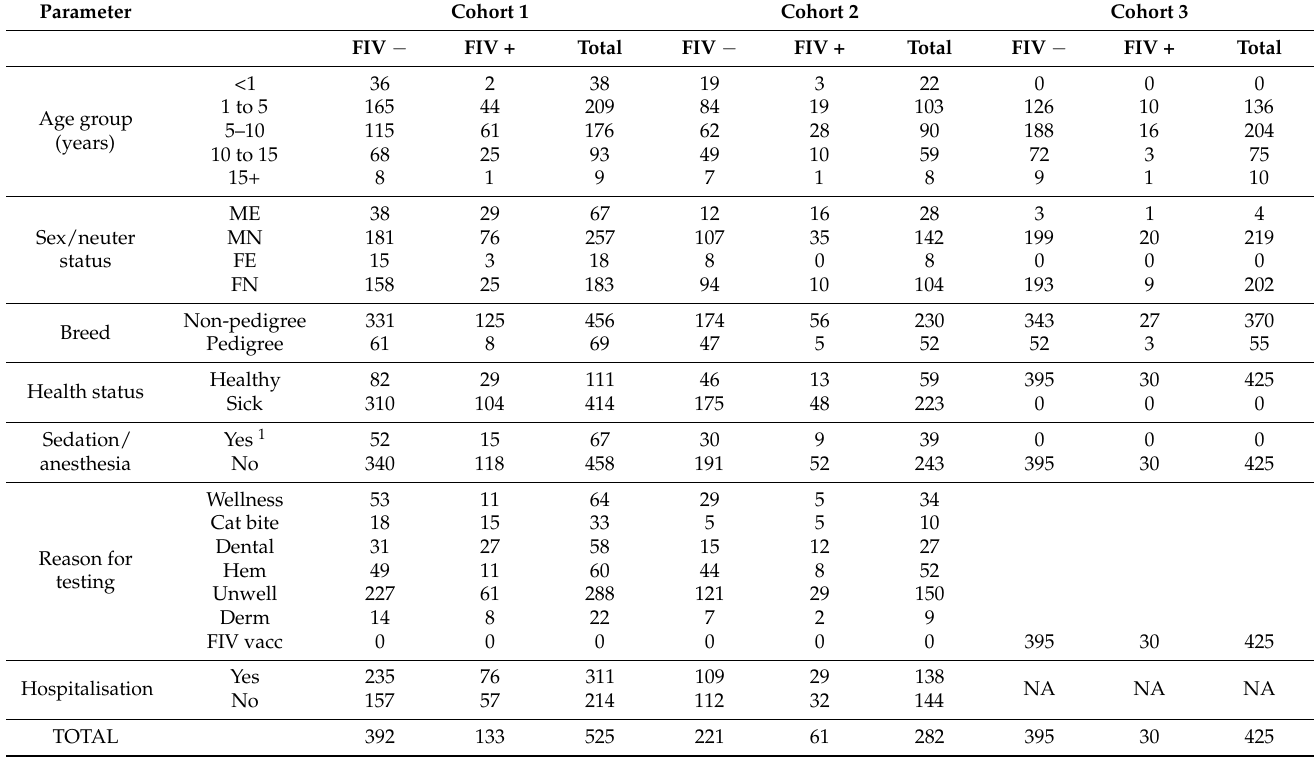
Table 1. Signalment details for cohort 1 ( n = 525; in-house hematology and blood biochemistry testing), cohort 2 ( n = 282; external hematology and blood biochemistry testing) and cohort 3 ( n = 425; FIV vaccine efficacy study). ME = male entire, MN = male neutered, FE = female entire, FN = female neutered. Wellness = wellness examination, Cat bite = cat fight wounds, Dental = dental disease, Hem = hematological abnormality, Unwell = systemic illness, Derm = dermatological disease (refer to Table 2 for a complete description of these categories). FIV vacc = FIV vaccine efficacy field study. NA = not available.